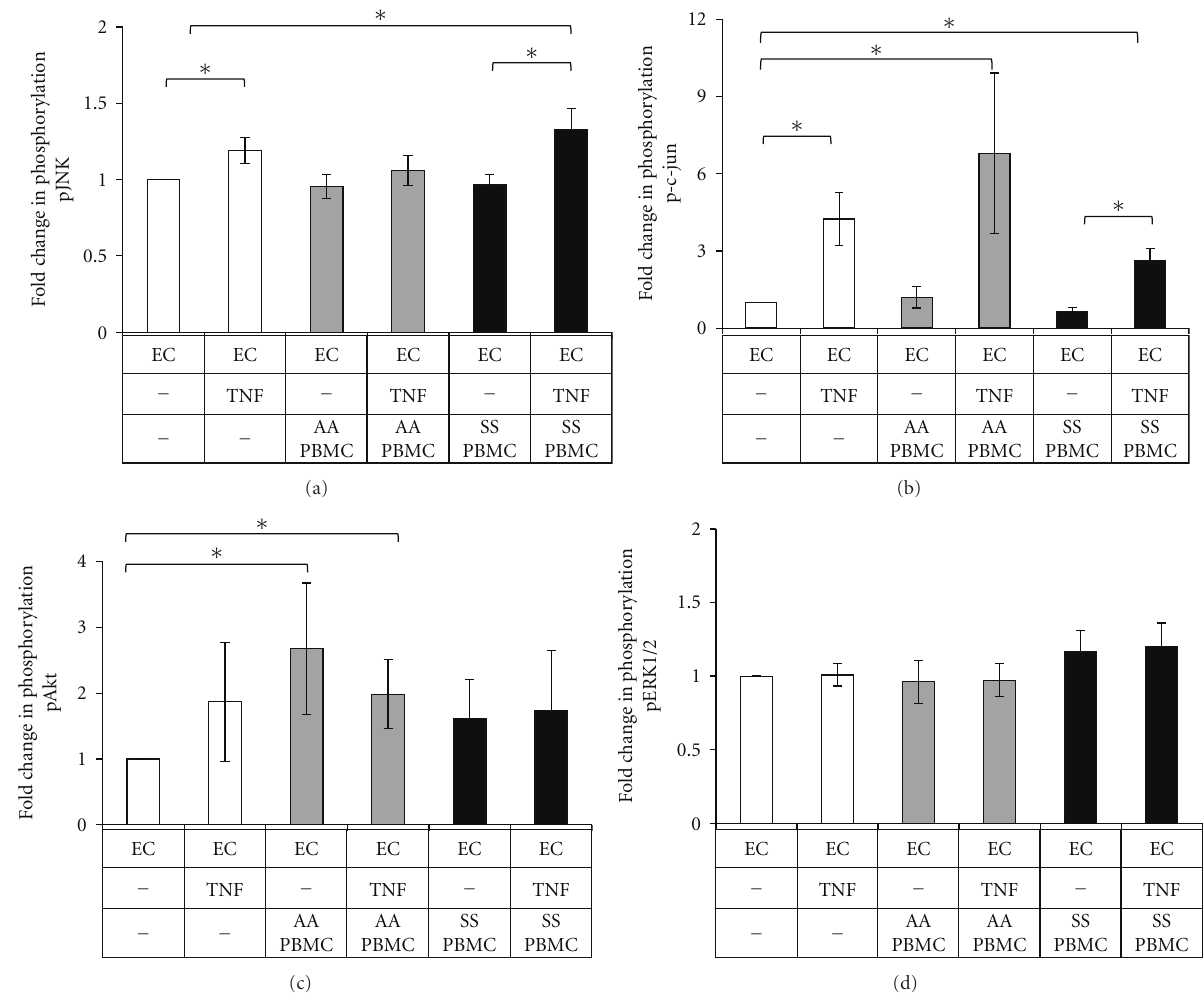
Figure 2: TNF α and PBMC interactions increase JNK and Akt phosphorylation. Confluent HAECs were cocultured with peripheral blood mononuclear cells isolated from AA or SS donors, and lysates were collected for kinase analysis. Levels of phosphorylated (a) JNK, (b) c- Jun, (c) Akt, and (d) ERK1/2 were measured, and phosphorylated kinase signals were normalized to unstimulated HAEC control ( n = 3, ∗ P < 0 . 05, SEM bars shown).